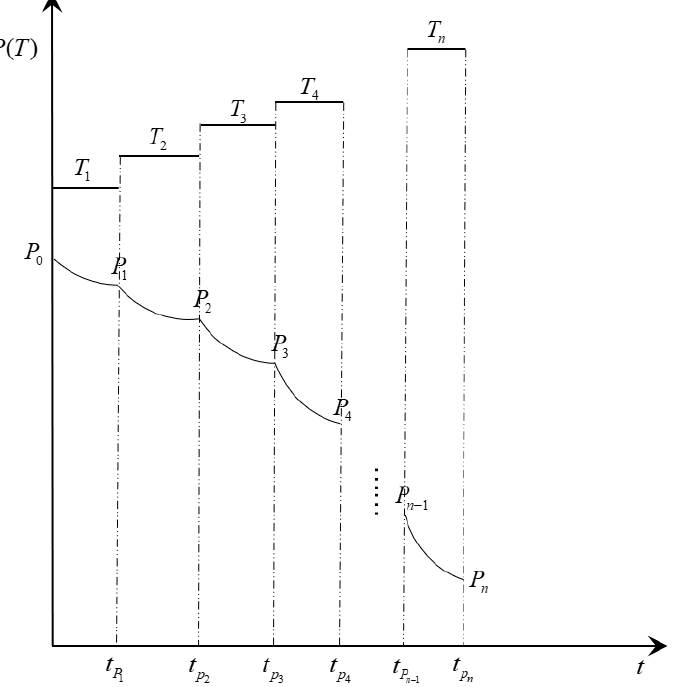
Figure 1. Schematic diagram of step stress loading and performance degradation.